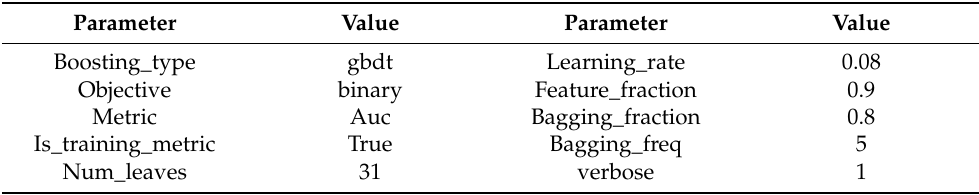
Table 5. LightGBM parameters.